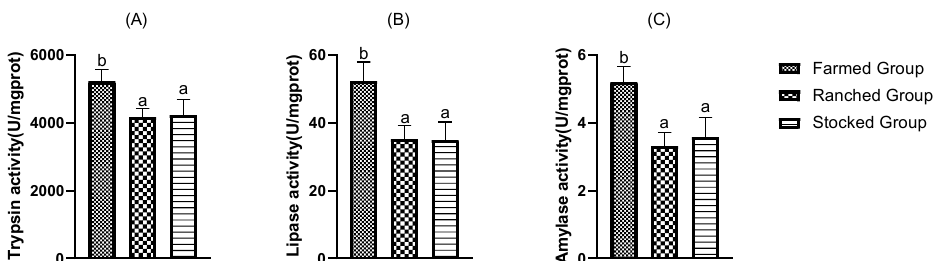
Figure 2. Results of digestive enzyme activities of three groups. ( A ) Trypsin activity; ( B ) lipase activity; ( C ) amylase activity. Data are expressed as mean ± SD ( n = 10). Different letters on the error line indicate significant differences ( p < 0.05). The absence of statistical signs denotes no statistically significant differences among treatments ( p > 0.05).